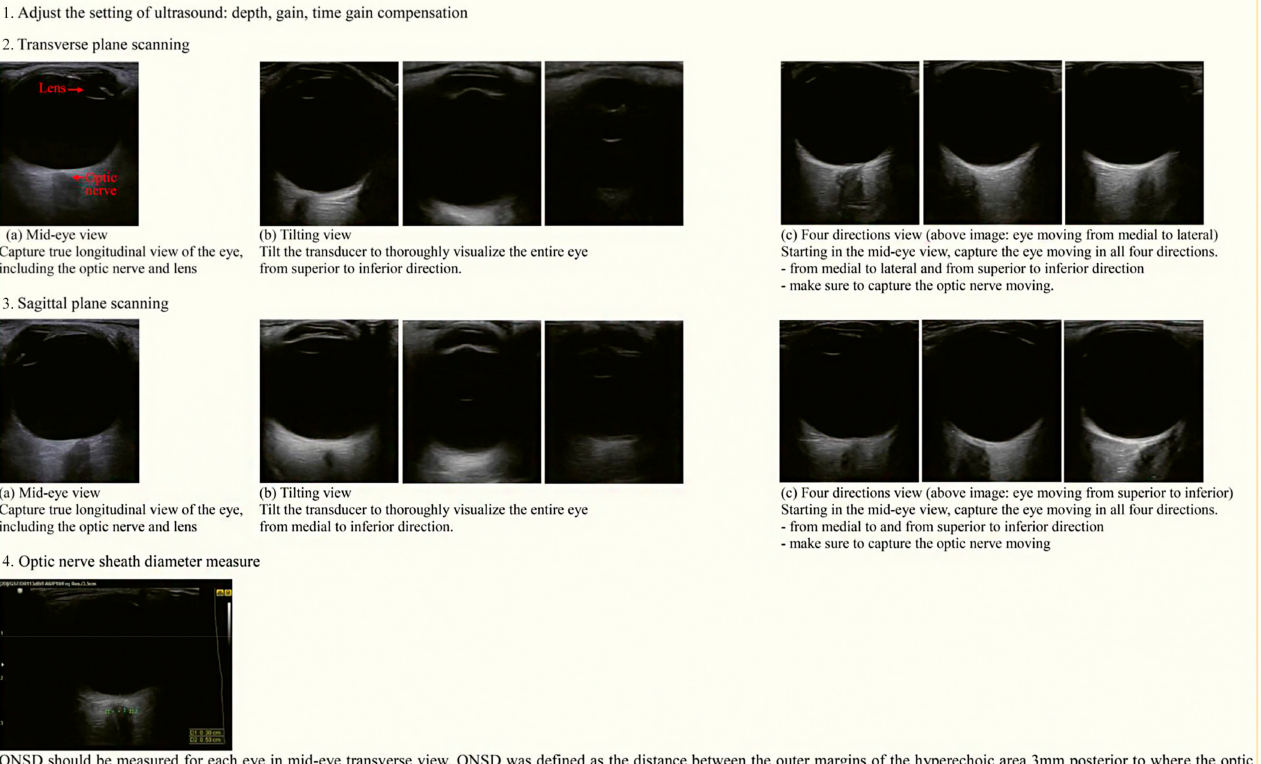
Figure 2. The ocular POCUS scan protocol. 1. Adjust the setting of ultrasound, 2. Transverse plane scanning, 3. Sagittal plane scanning, 4. ONSD measure. Abbreviations: POCUS, point-of-care ultrasound; ONSD, optic nerve sheath